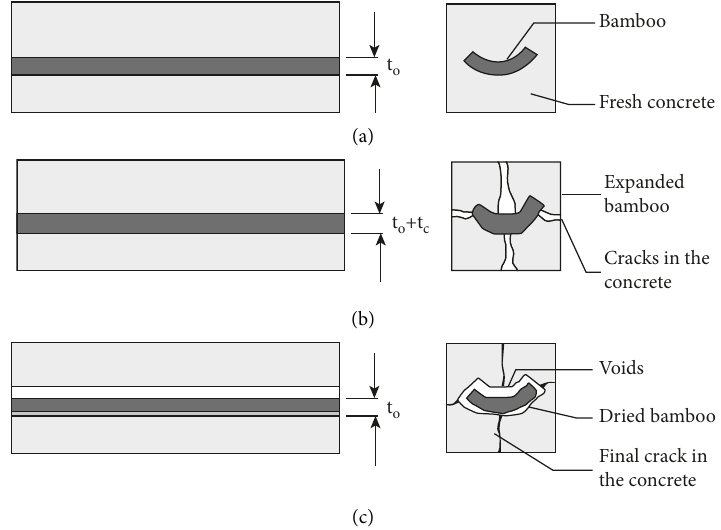
Figure 2: Water absorption behavior of bamboo in concrete reinforcements: (a) bamboo in fresh concrete; (b) bamboo during curing of concrete; (c) bamboo after cured concrete [75]. Reproduced with permission from Elsevier.